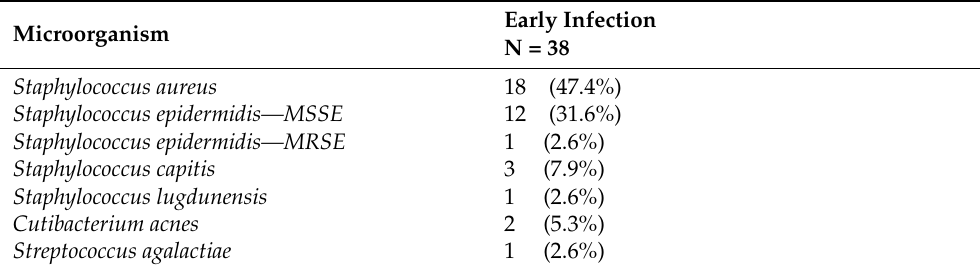
Table 1. Distribution of the detected microorganism of the 38 patients with acute periprosthetic infection.